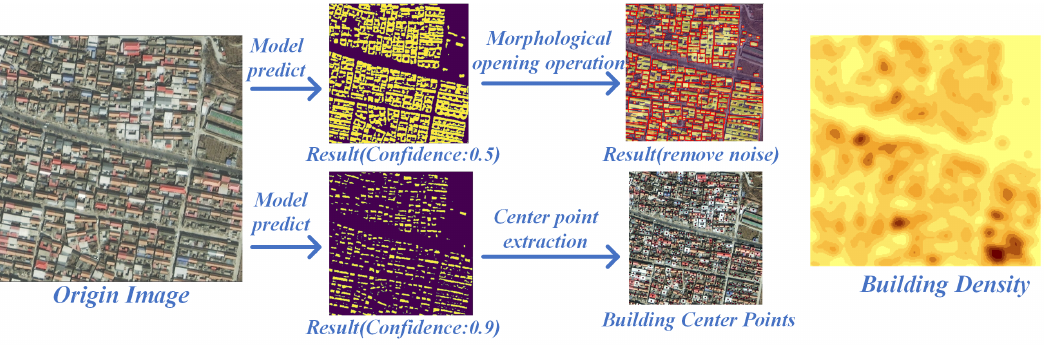
Figure 3. This group of images represents the process diagram for post-processing of building semantic segmentation for photovoltaic potential assessment.